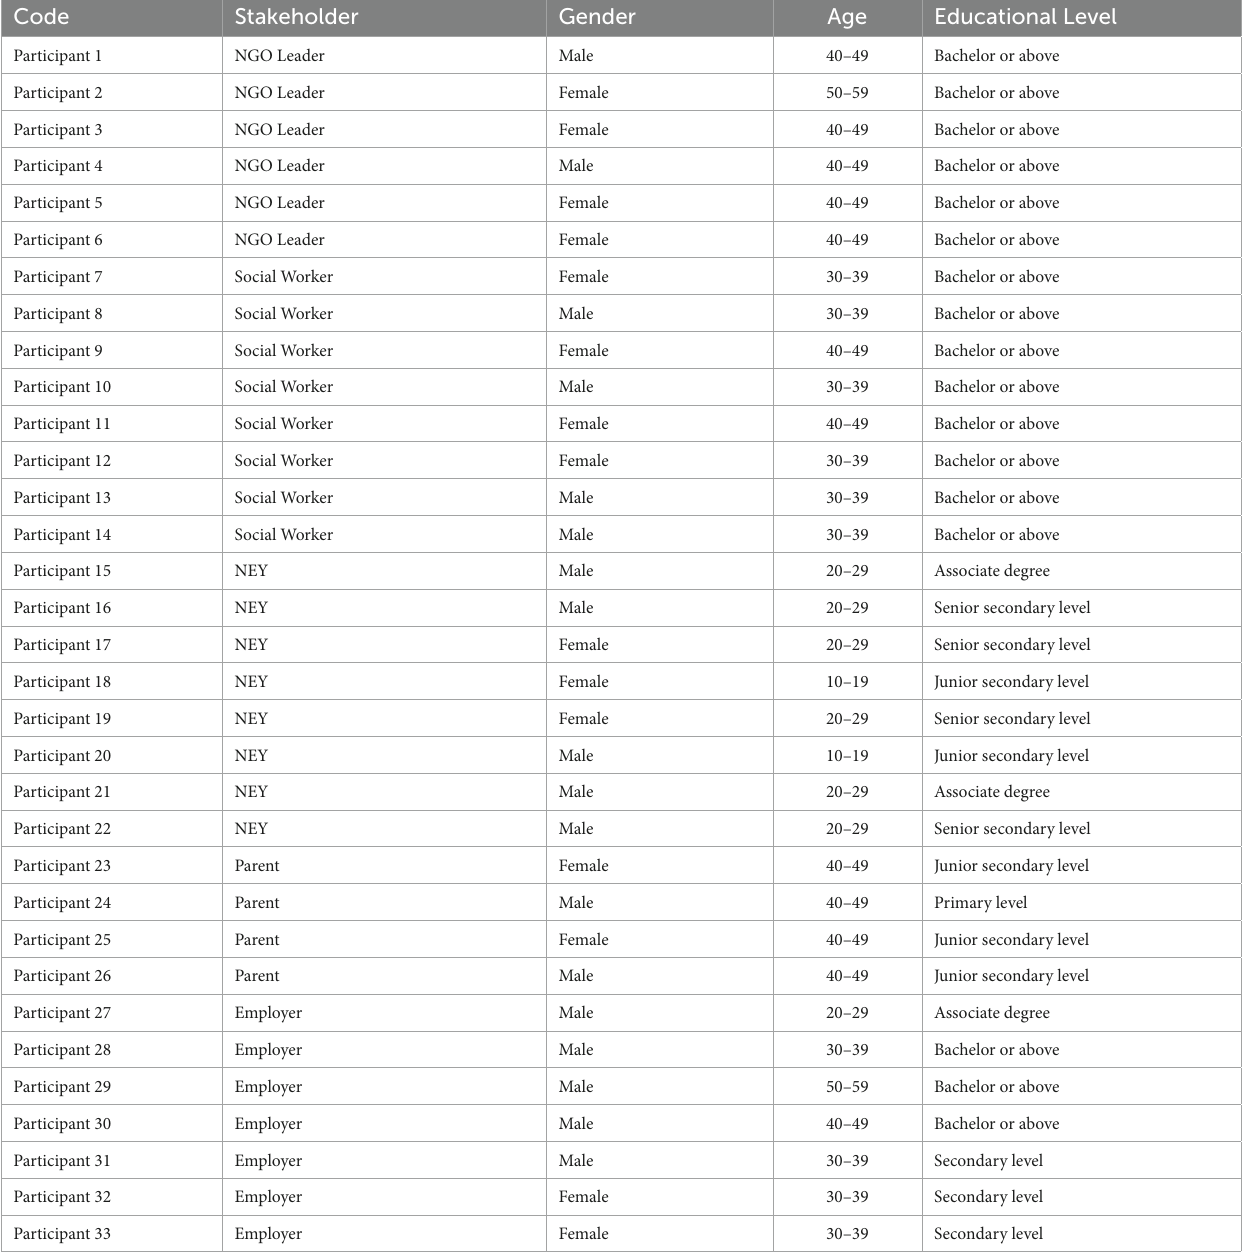
TABLE 2 Background information of focus group